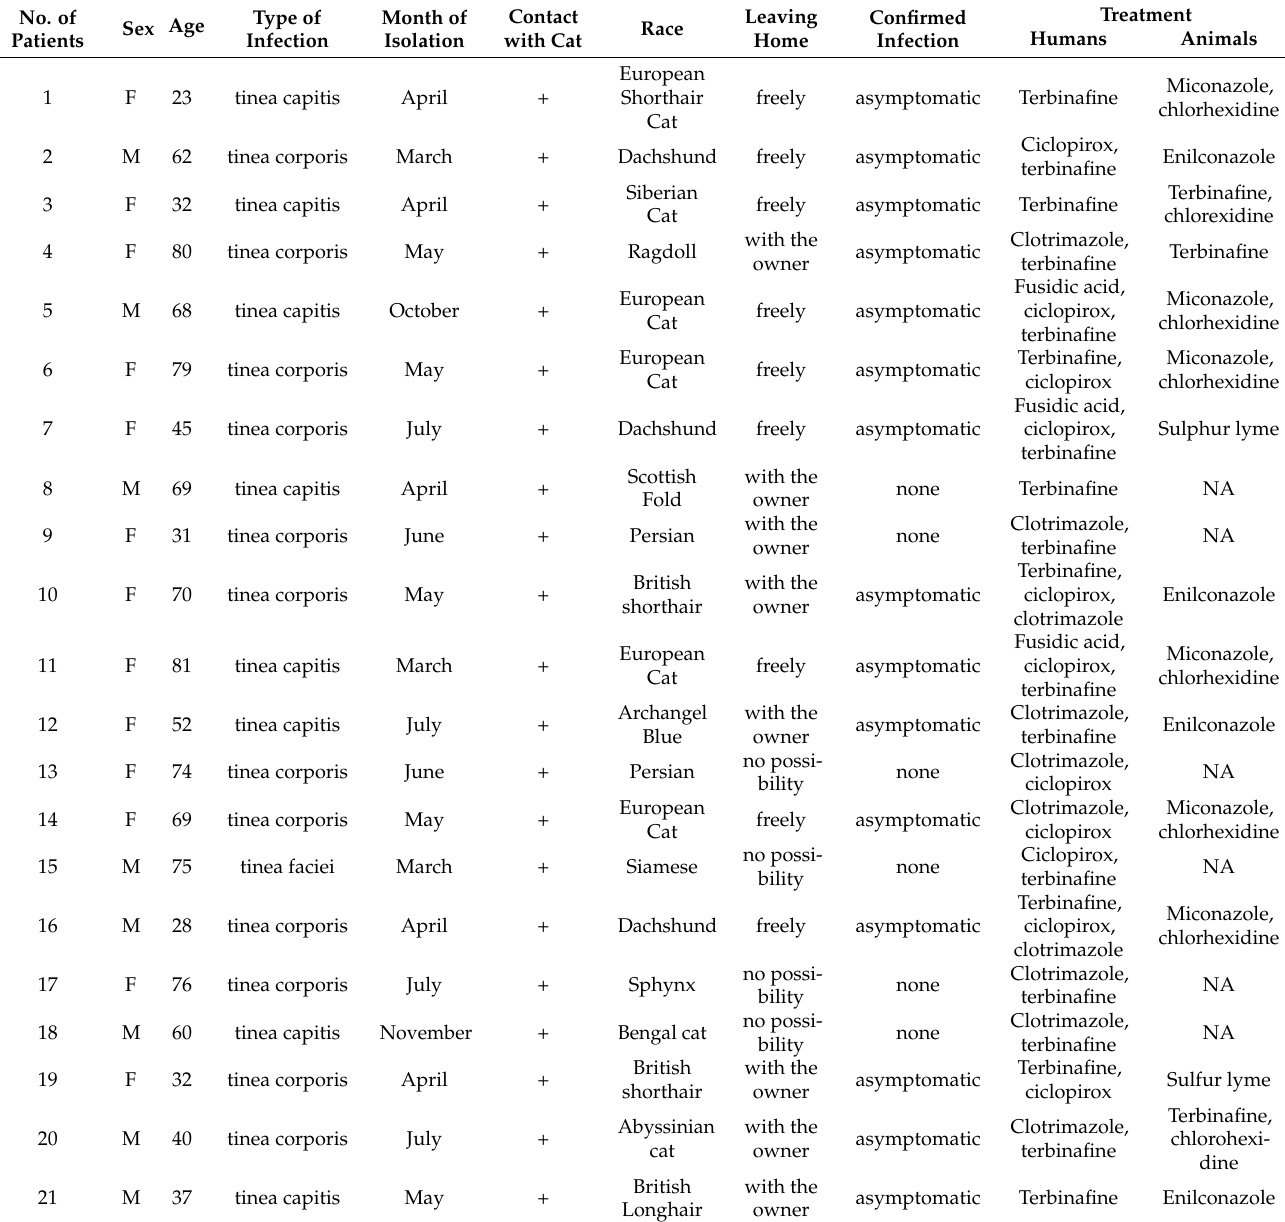
Table 1. Clinical isolates of Trichophyton quinckeanum examined in this study with